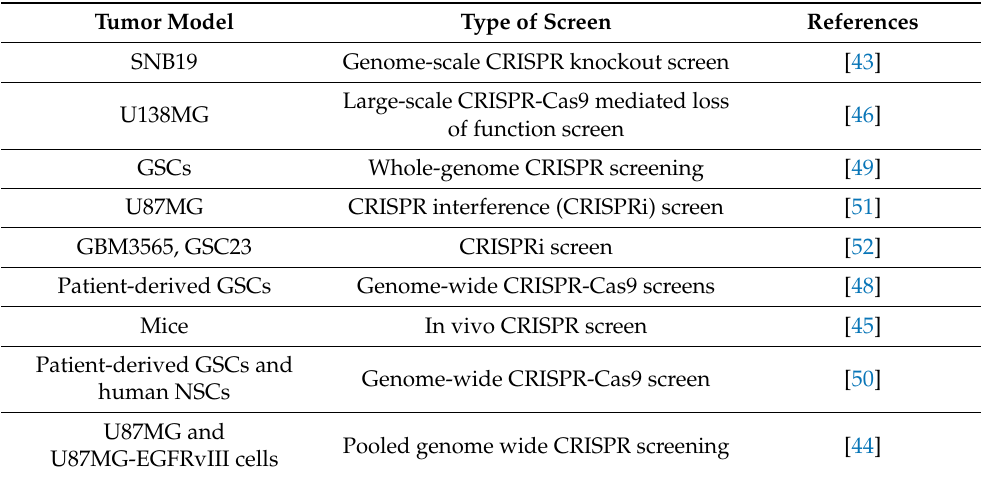
Table 1. CRISPR-Cas9 genome-wide screens used in